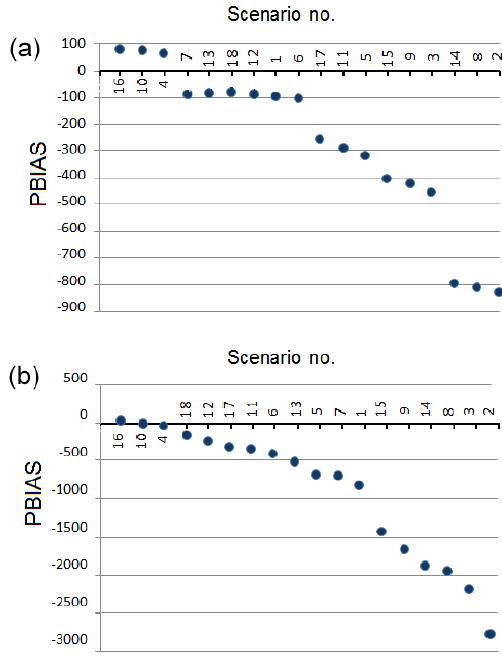
Figure 8. Values of PBIAS calculated for prediction of (a) dis- charge and (b) sediment yield, from the 18